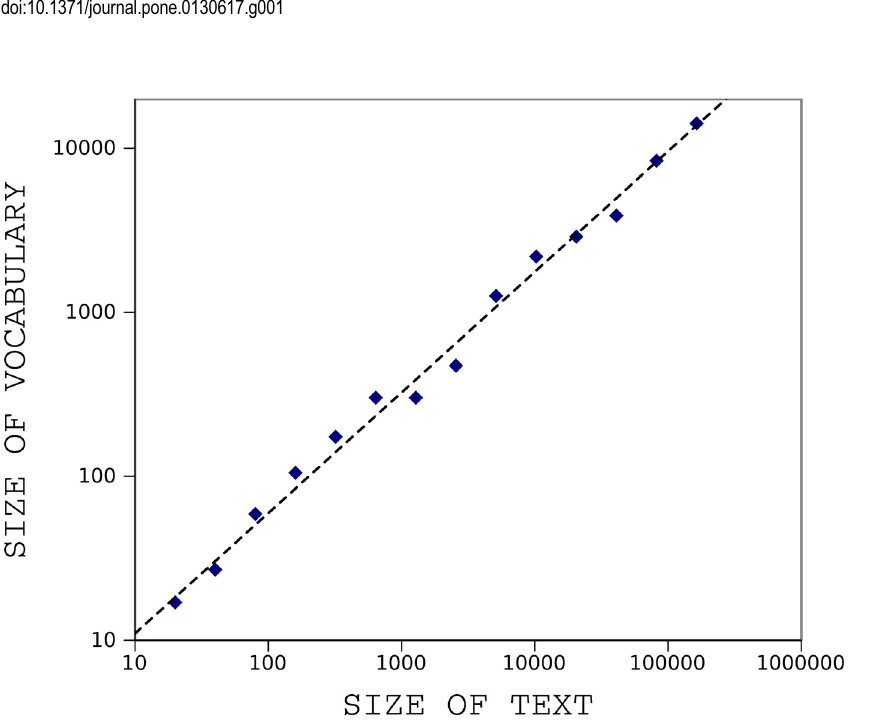
Fig 2. Heap ’ s law for the book The Origin of Species . Size of vocabulary increases as size of text increases, in form of power law. The Heap curve follows a straight line with a slope of 0.73 when plotted on a double-logarithmic scale.